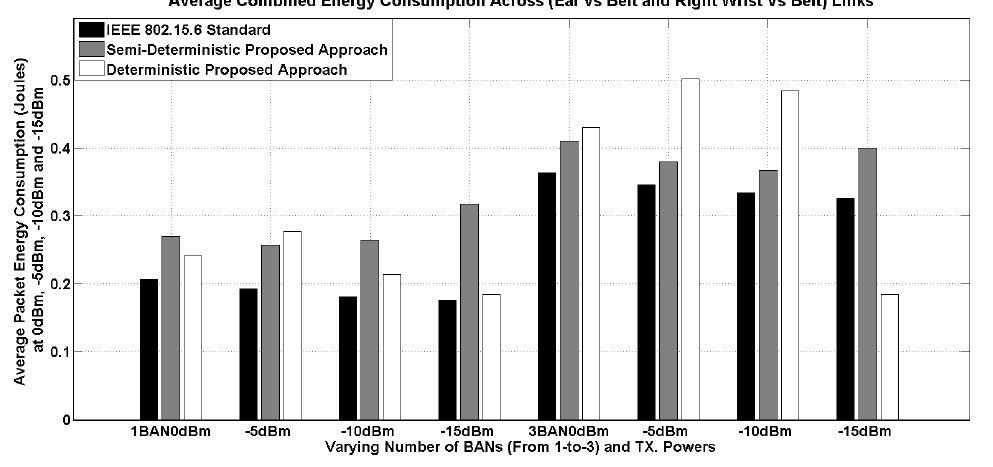
Figure 15. Average energy consumption at varying transmission power for one and three BANs (having three nodes per